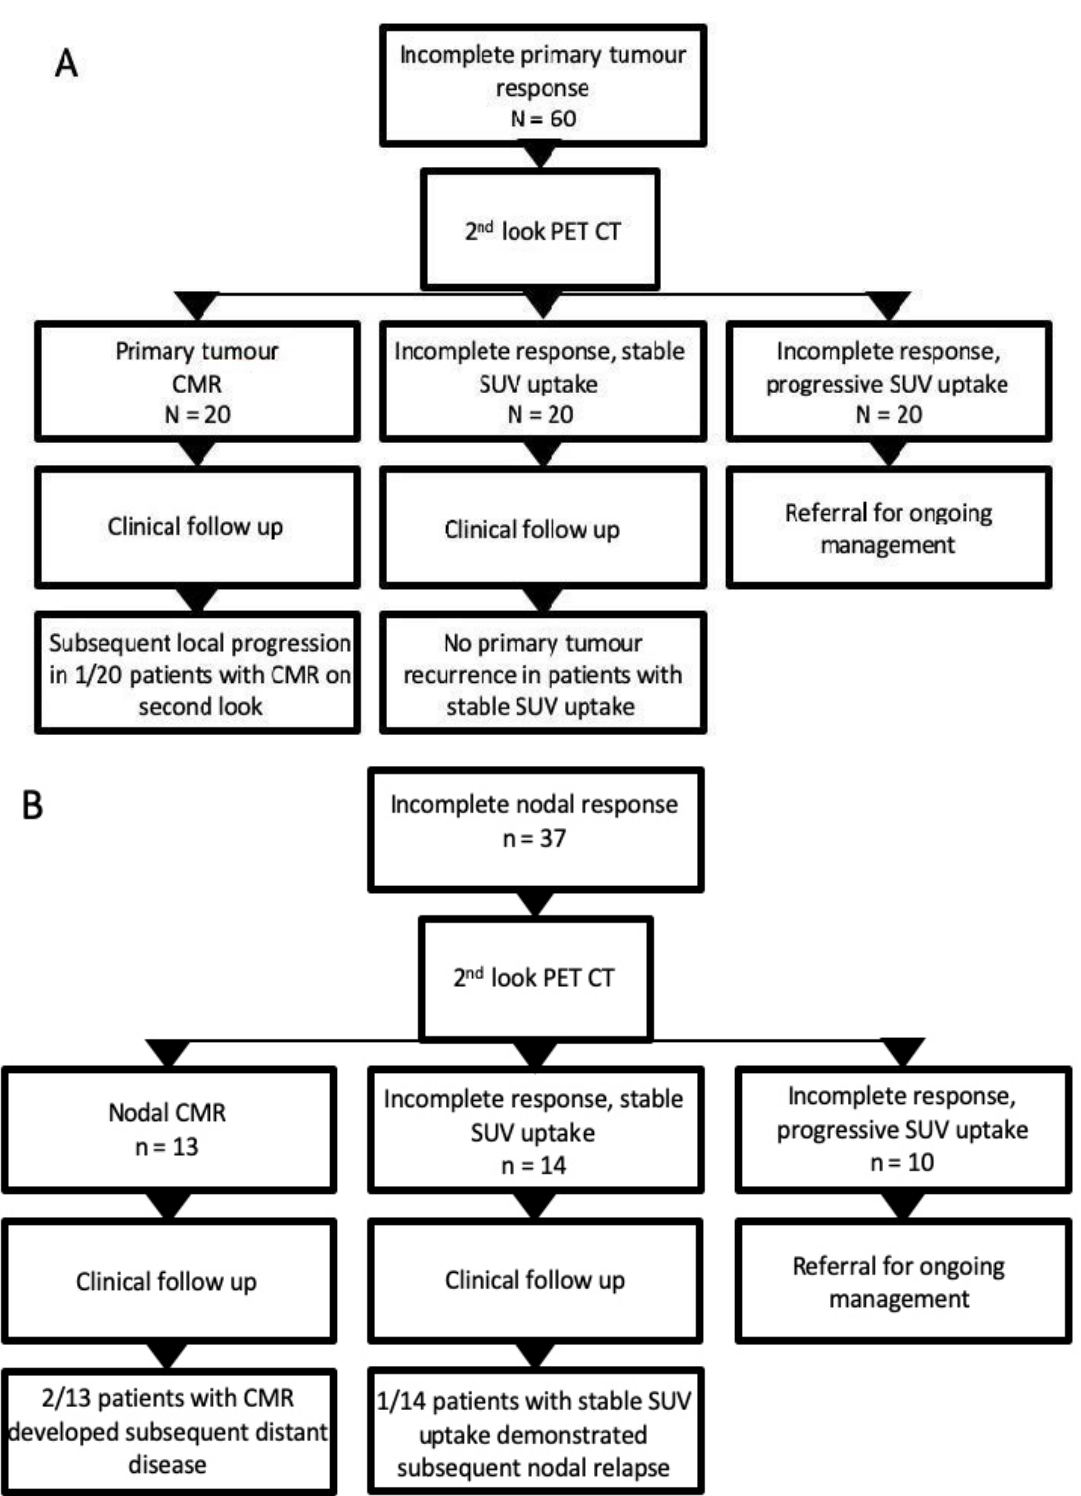
Figure 2. Flow chart illustrating outcomes of patients with incomplete primary tumour or nodal response on initial response assessment PET-CT. ( A ) Outcome of patients with residual FDG uptake at the primary tumour site on initial post-treatment PET CT; ( B ) outcome of patients with residual nodal uptake at initial response assessment PET-CT.